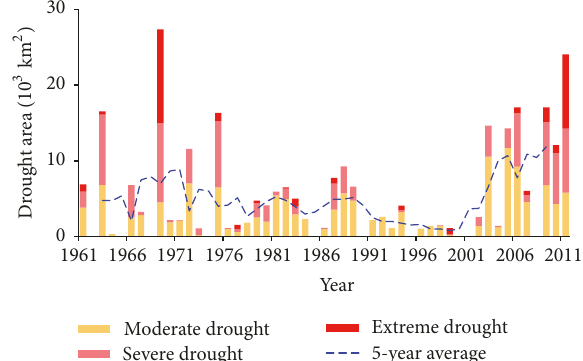
Figure 12: Annual variation of drought area from 1961 to 2011. In this study, the drought area means the area of farmland affected by drought.